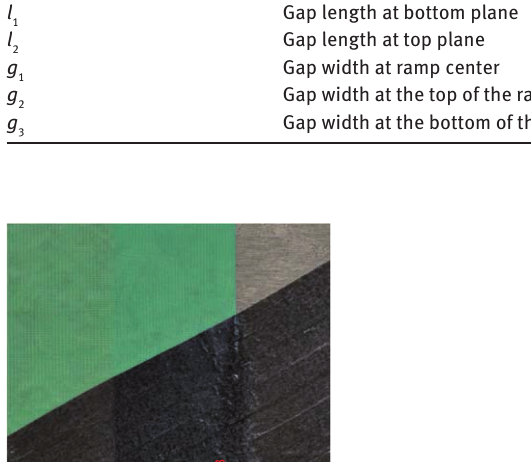
Figure 12 Resulting steering angle as function of path angle and ramp angle.